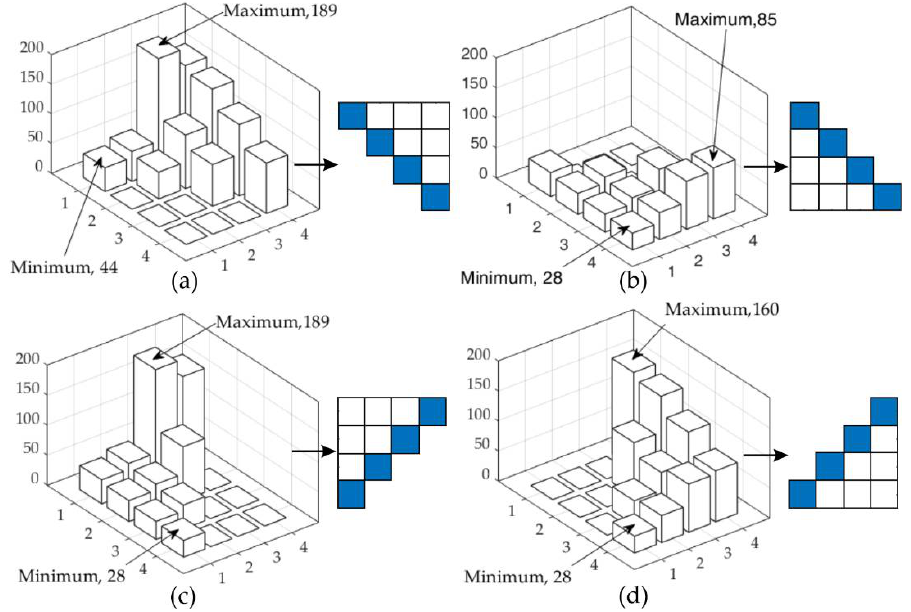
Figure 4. Division of frame image in two triangular frames with four patterns ( a ) up triangular ( b ) down triangular ( c ) left triangular ( d ) right triangular. Obtain the box and each pattern so that l and k can be calculated by IMax / h and IMin / h , where IMax and IMin are the maximum and minimum values of intensity in each